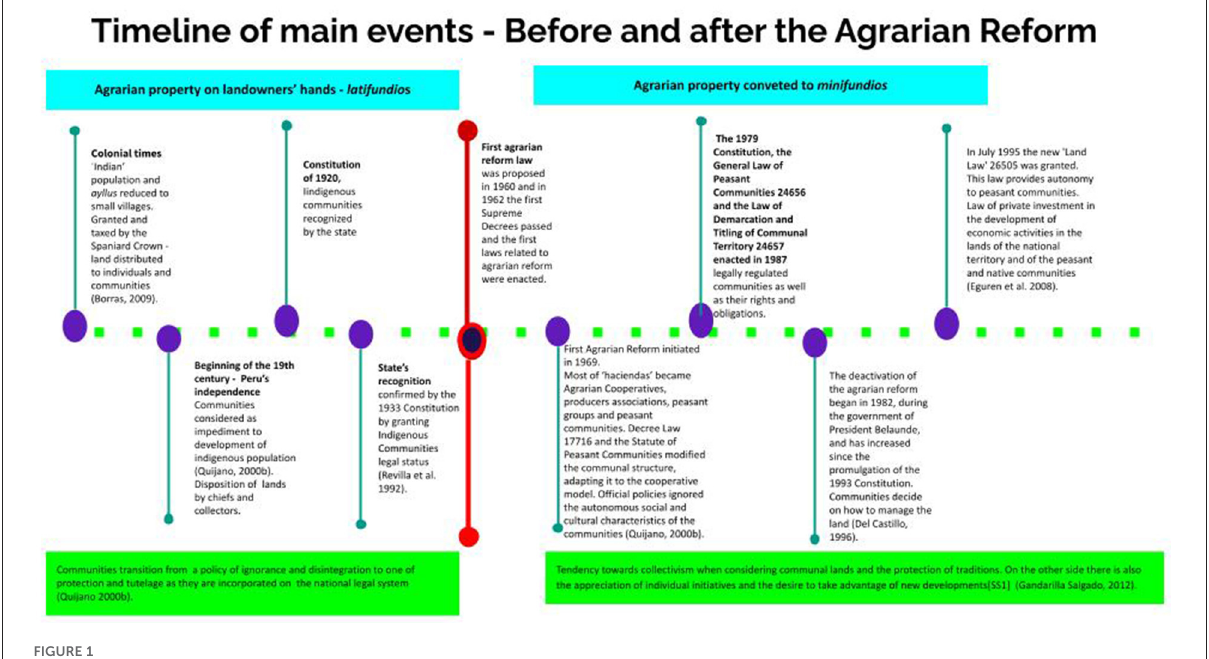
FIGURE1 Timeline of events before and after agrarian